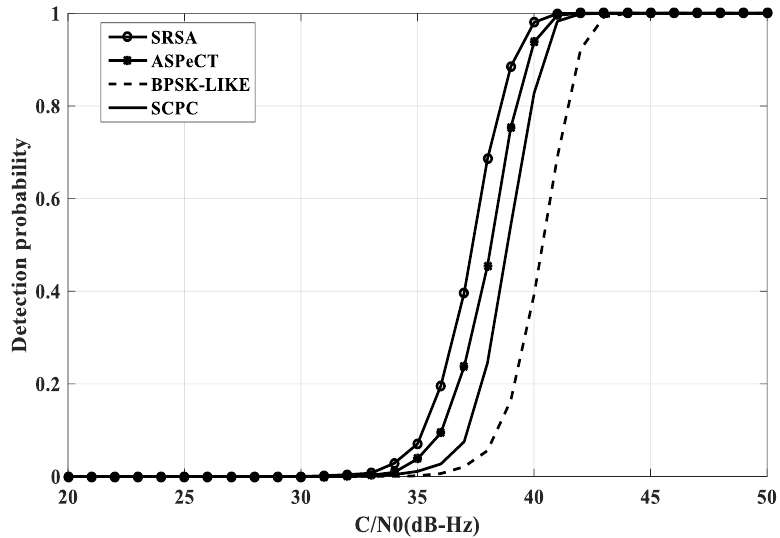
Figure 13. The acquisition probability of BOC(1, 1).